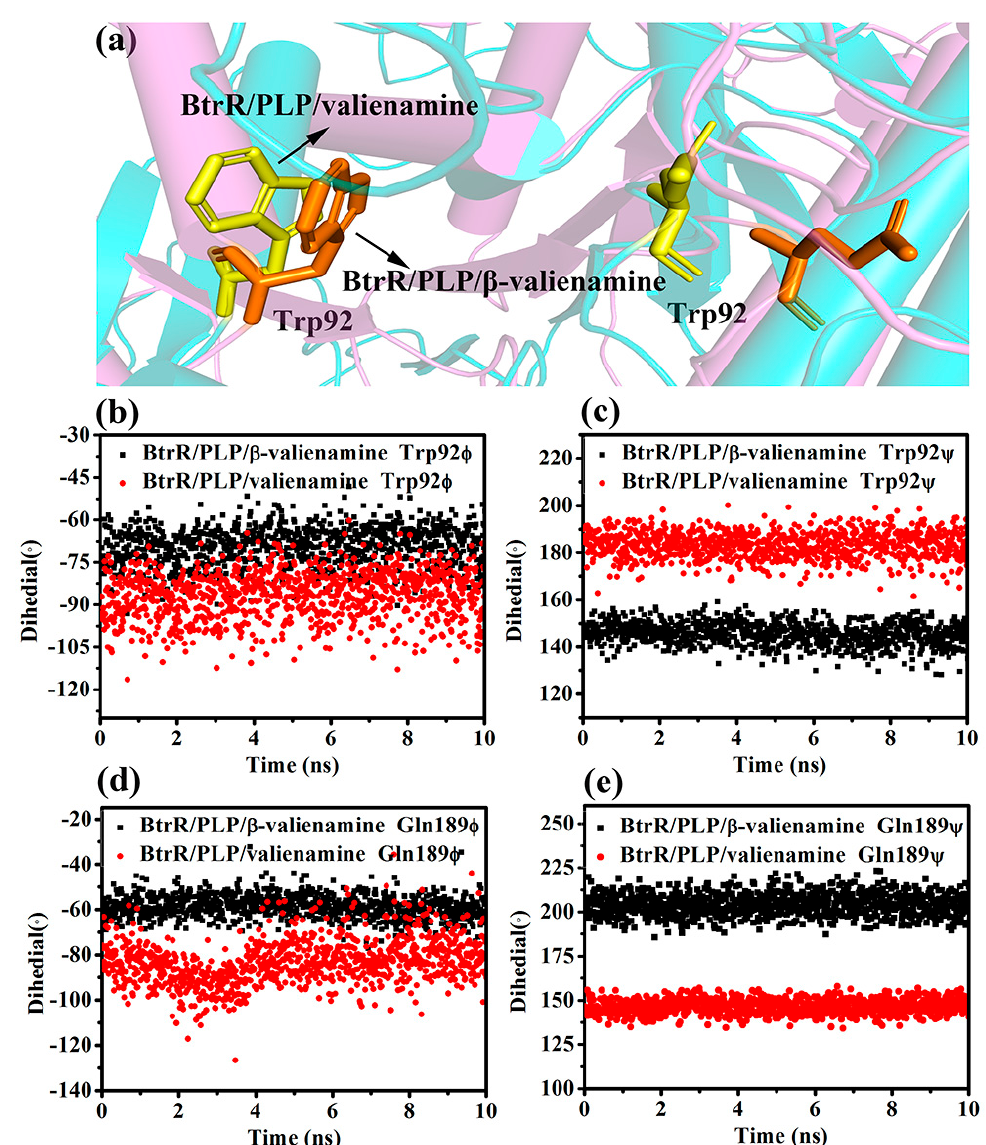
Figure 9. ( a ) The dihedrals of Trp92 and Gln189 in the BtrR channel. ( b , c ) Comparison of the dihedrals of Trp92 during the dissociation process. ( d , e ) Comparison of the dihedrals of Gln189 during the dissociation process.